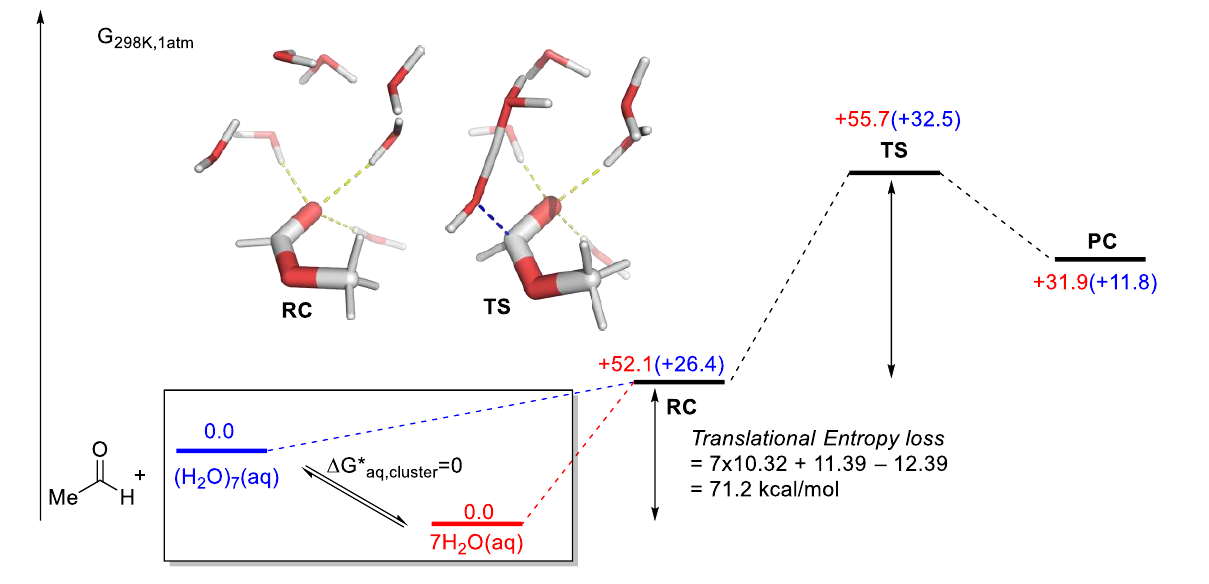
Figure 17. All values in the free energy profile are in kcal/mol and computed at CPCM(H 2 O at PBEh-3c)/DLPNO-CCSD(T)/CBS//CPCM(H 2 O)/PBEh-3c. CBS is based on a 2-point extrapolation with the def2-TZVPP and def2-QZVPP basis sets. For values in blue, the water cluster is the reference. For values in red, isolated water molecules are the reference. For comparison, key values from Pliego and co-workers [100] at MP4/TZVPP+diff//CPCM/X2LYP/6- 31+G(d): ΔG ‡ (RC to TS) = 24.5 kcal/mol and ΔG(reference to RC) = +52.7 kcal/mol. For Wang and Cao [107] at CPCM/B3LYP/6-311+G(2df,2p): ΔG ‡ (RC to TS) = 25.4 kcal/mol. Correction of water concentration is not included.